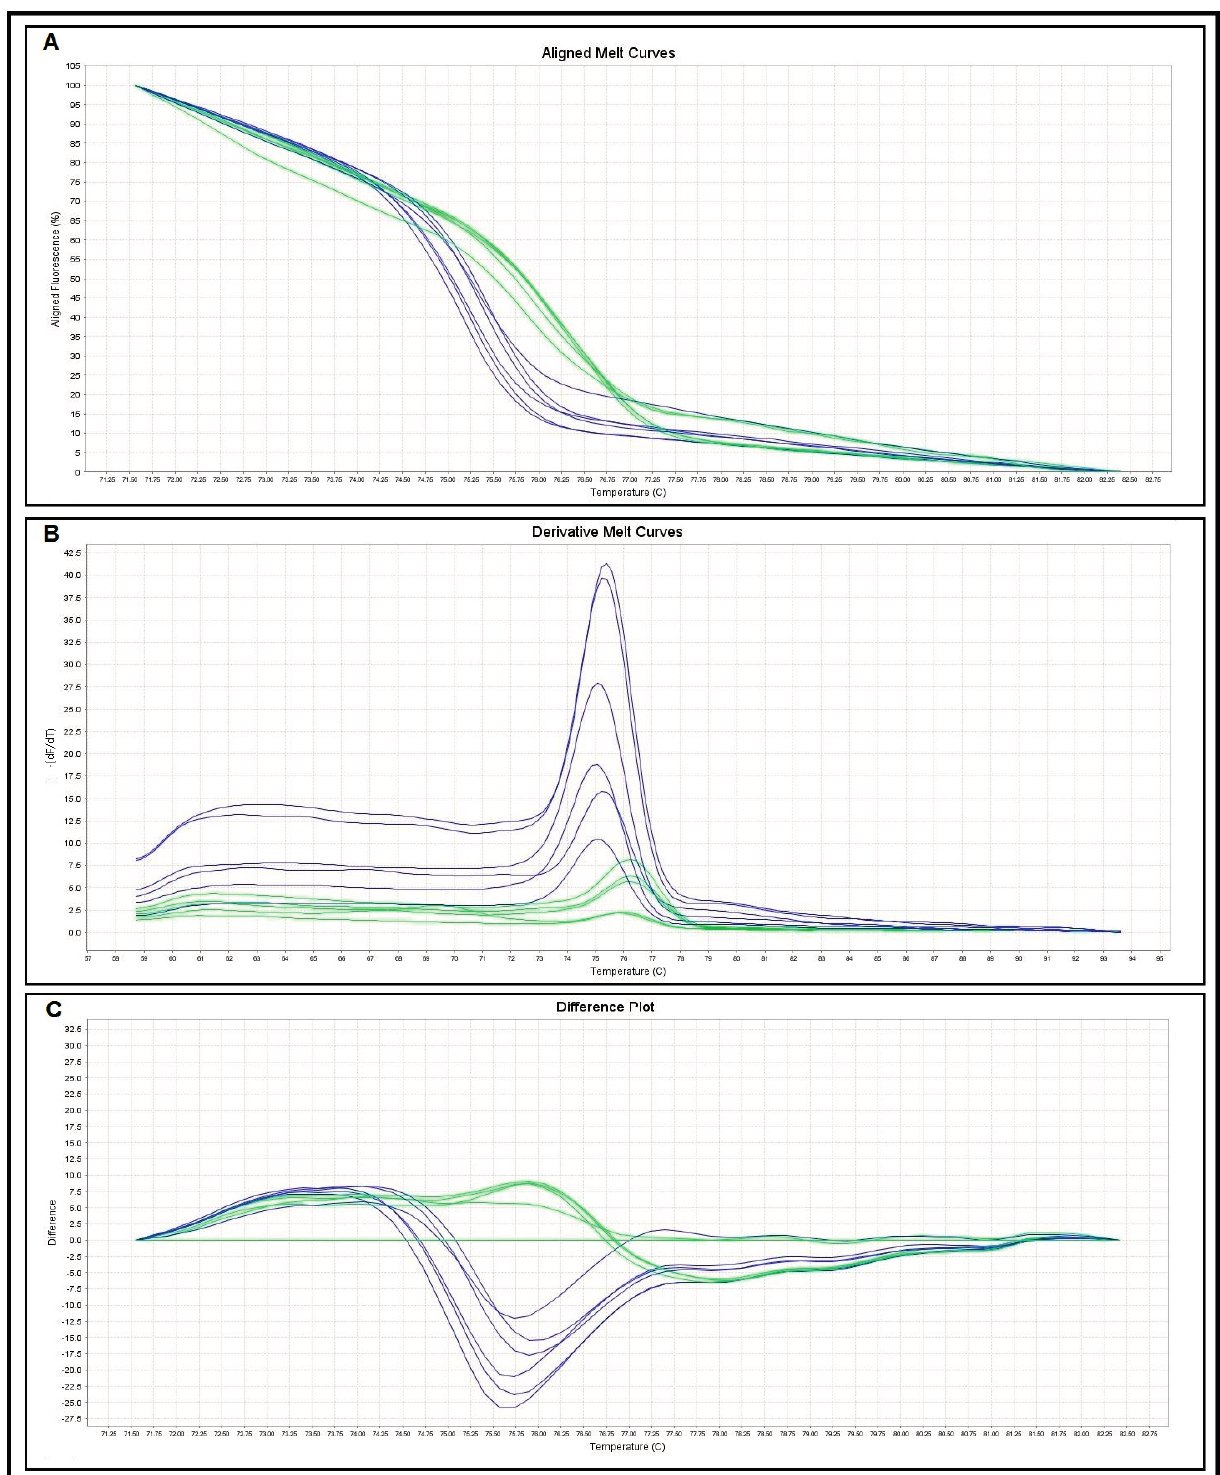
Figure 2. Categorization of Schistosoma species based on HRM curve. Representative profiles of the melting curves (( A ) aligned melt curves; ( B ) derivative melt curves; ( C ) difference plot curves) of COX 1 amplicons for S. mansoni (green) and S. haematobium (blue), fluorescence is plotted against degrees Celsius